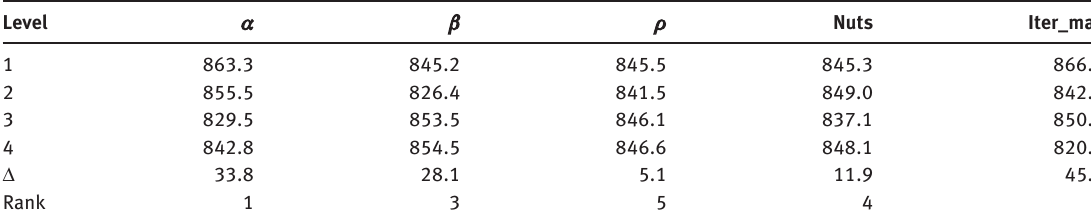
Table 6: Analysis of Standard